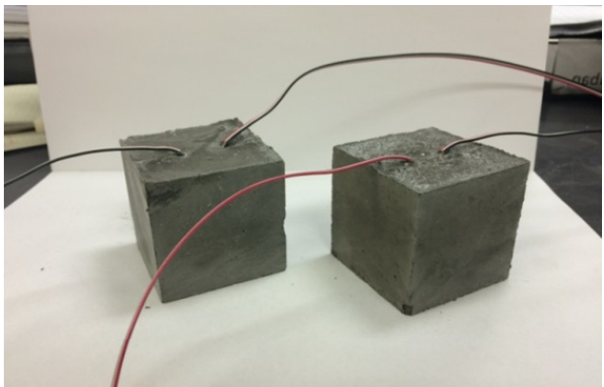
Figure 3. 2” x 2” test blocks of cementitious materials. Multiple blocks were prepared with CCNT, SM and bare CNT (control) impregnated in the blocks. Additional blocks were prepared with only modified starch impregnated in the blocks and with no impregnation (bare cement). The electrical wires were fitted for the measurement of piezo-responses from the blocks when subjected to dynamic